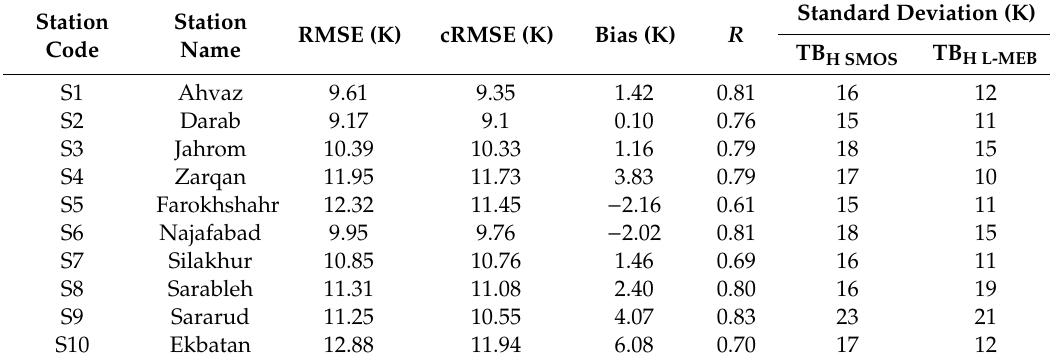
Table 3. Statistical results of the TB H SMOS compared to TB H L-MEB at the stations.